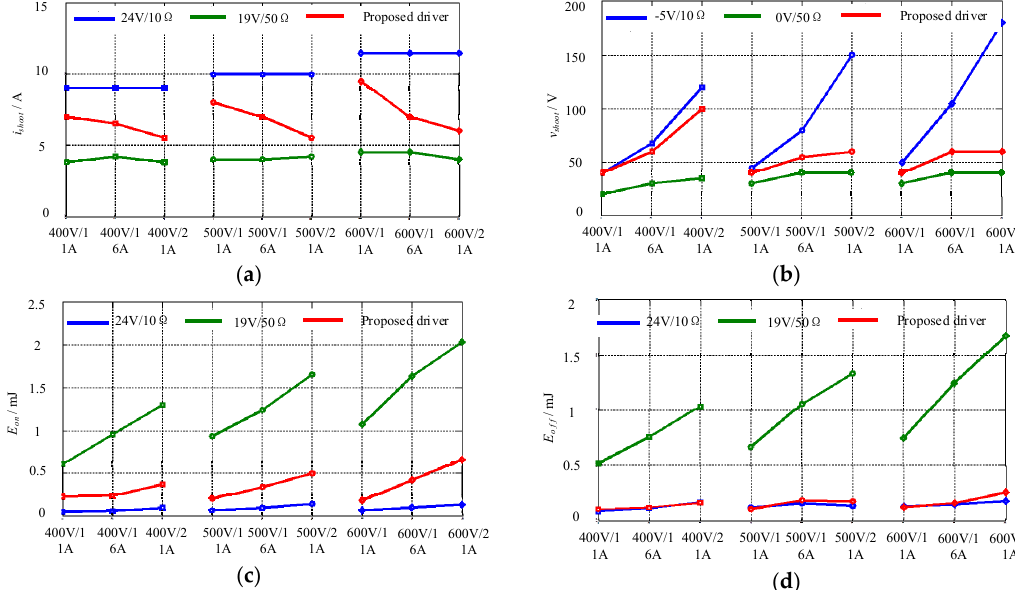
Figure 12. Experimental results under the different working conditions: ( a ) Overshoot current, ( b ) Overshoot voltage, ( c ) Turn-on loss, and ( d ) Turn-off loss.